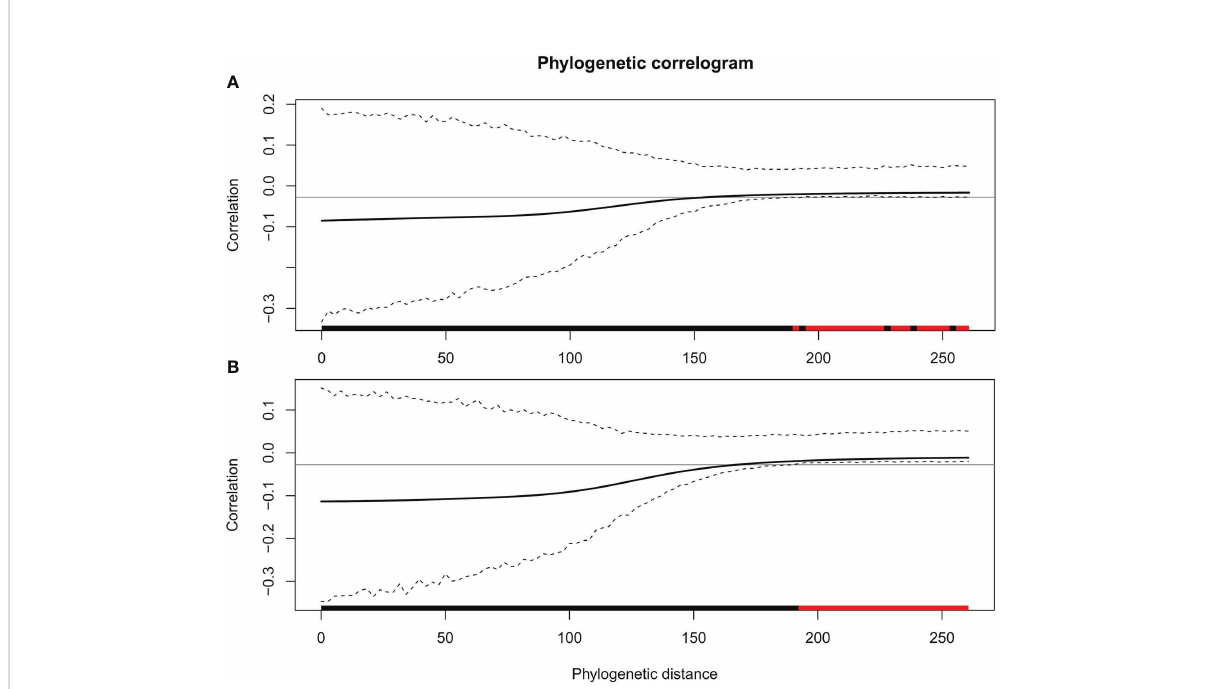
FIGURE 3 Phylogenetic correlograms for two traits: (A) p o and (B) p tlp . The solid bold black line represents the Moran ’ s I index of autocorrelation, and the dashed black lines represent the lower and upper bounds of the con fi dence envelope (95%). The horizontal black line indicates the expected value of Moran ’ s I under the null hypothesis of no phylogenetic autocorrelation. The colored bar shows whether the autocorrelation is signi fi cant based on the con fi dence interval (red) or not (black).